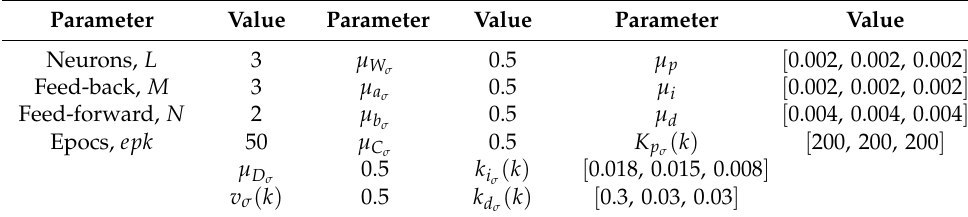
Table 1. Proposed values for wavenet-IIR PID controller.